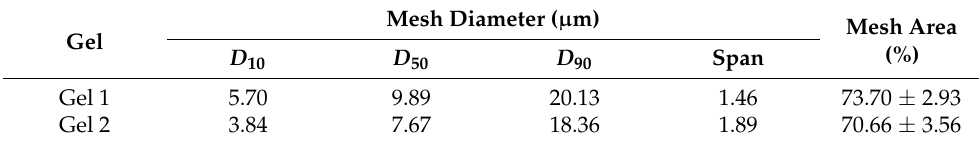
Figure 5. Cryo-SEM images of Gel 1 (20 kDa PEG) ( a , b ) and Gel 2 (40 kDa PEG) ( c , d ). Scale bar: ( a , c ) 40 μ m; ( b , d ) 20 μ m. ( a , c ) 40 µ m; ( b , d ) 20 µ m. Table 2. Mesh size of Gel 1 and Gel